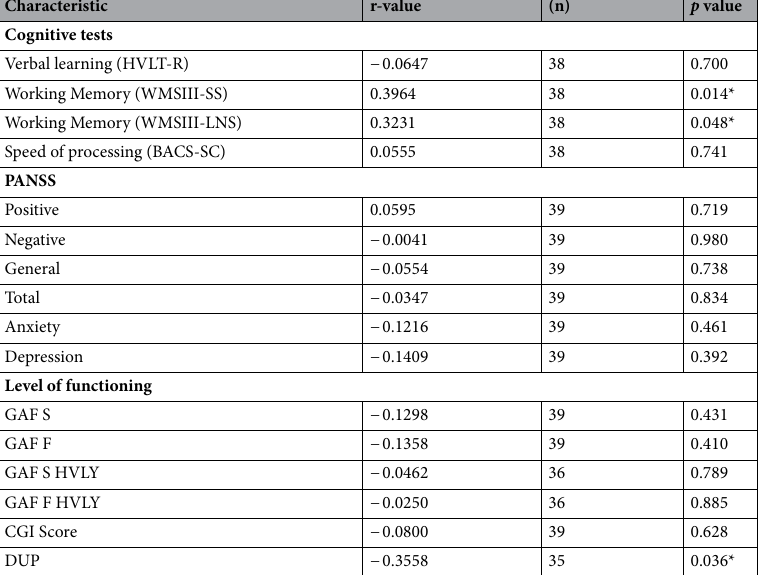
Table 3. Spearman’s rank correlation of plasma bilirubin levels with cognitive performance, clinical symptoms and DUP in individuals with FEP. Abbreviations: FEP, first-episode psychosis; (n), number; HVLT-R; Hopkins Verbal Learning Test—Revised; WMSIII-SS, Wechsler Memory Scale-3rd Edition—Spatial Span; WMSIII- LNS, Wechsler Memory Scale-3rd Edition – Letter-Number Span; BACS-SC, Brief Assessment of Cognition in Schizophrenia—Symbol Coding; PANSS, Positive and Negative Syndrome Scale; GAF S, Global Assessment of Functioning Symptoms; GAF F, Global Assessment of Functioning Functions; HVLY, highest value last year; CGI, Clinical Global Impression; DUP, Duration of untreated psychosis. * p value <